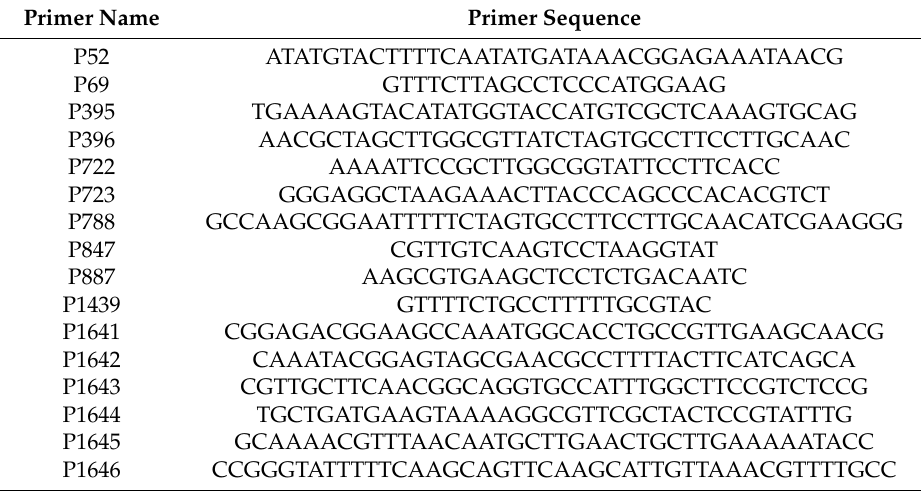
Table 1. Primers used during the research for the creation of the different Starmerella bombicola strains.